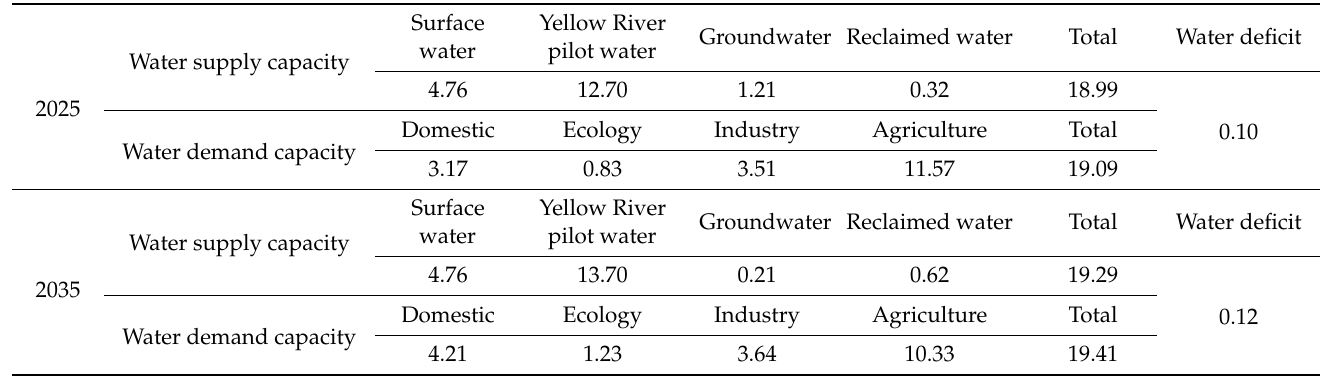
Table 2. The water supply and water demand balance analysis of Binzhou for 2025 and 2035 ( × 10 8 m 3